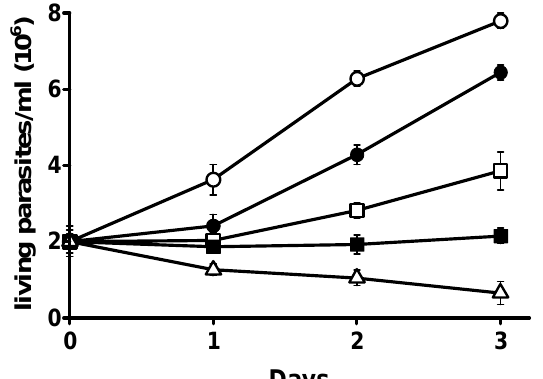
Parasites (2 × 10 6 parasites/mL) were incubated in the absence ( ○ ) or in the presence of 0.2 ( ● ), 0.5 ( □ ), 1.0 ( ■ ) or 2.5 ( ∆ ) μ g/mL of psilostachyin. Viability was measured by the trypan blue exclusion method. Values represent the means of three experiments ±